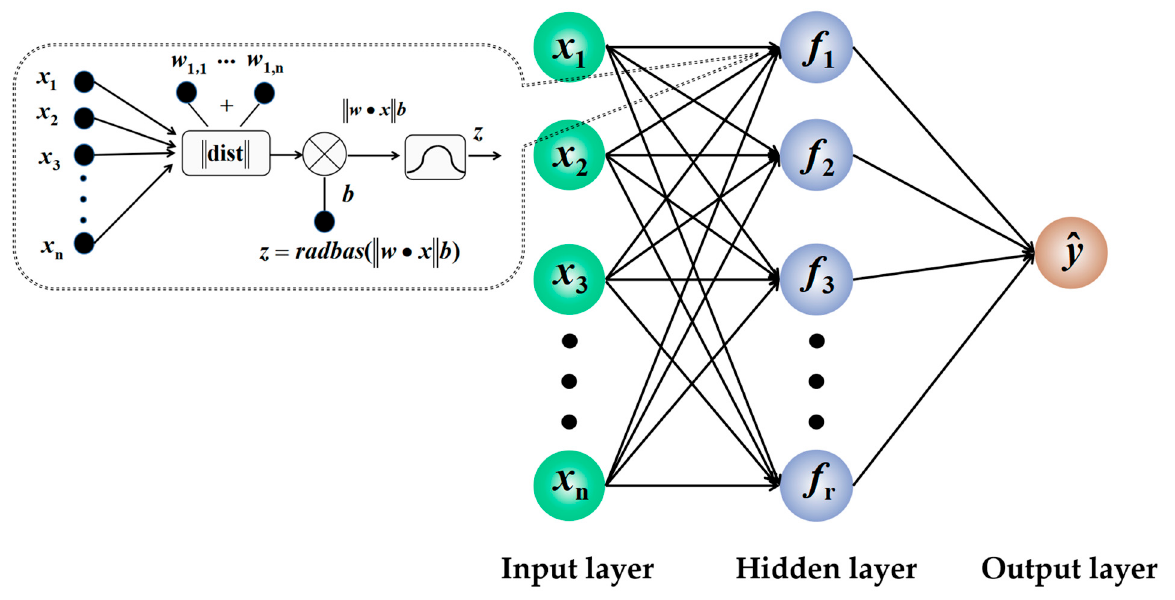
Figure 3. Structure diagram of RBF-ANN.